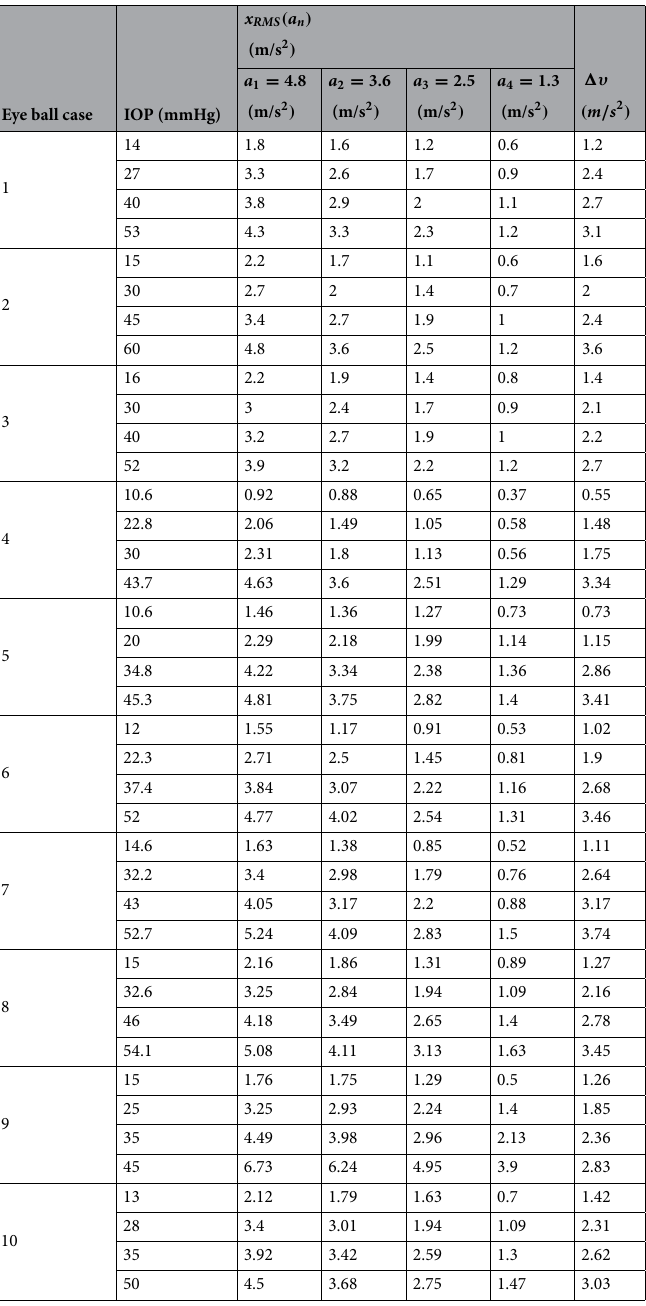
Table 2. RMS levels according to excitation magnitude and IOP. IOP intraocular pressure, RMS root mean square, x RMS ( a n ) acceleration root mean square in eyeball, a n acceleration root mean square in excitation {n = 1,2,3,4}, �υ = change in the magnitude of the vibration